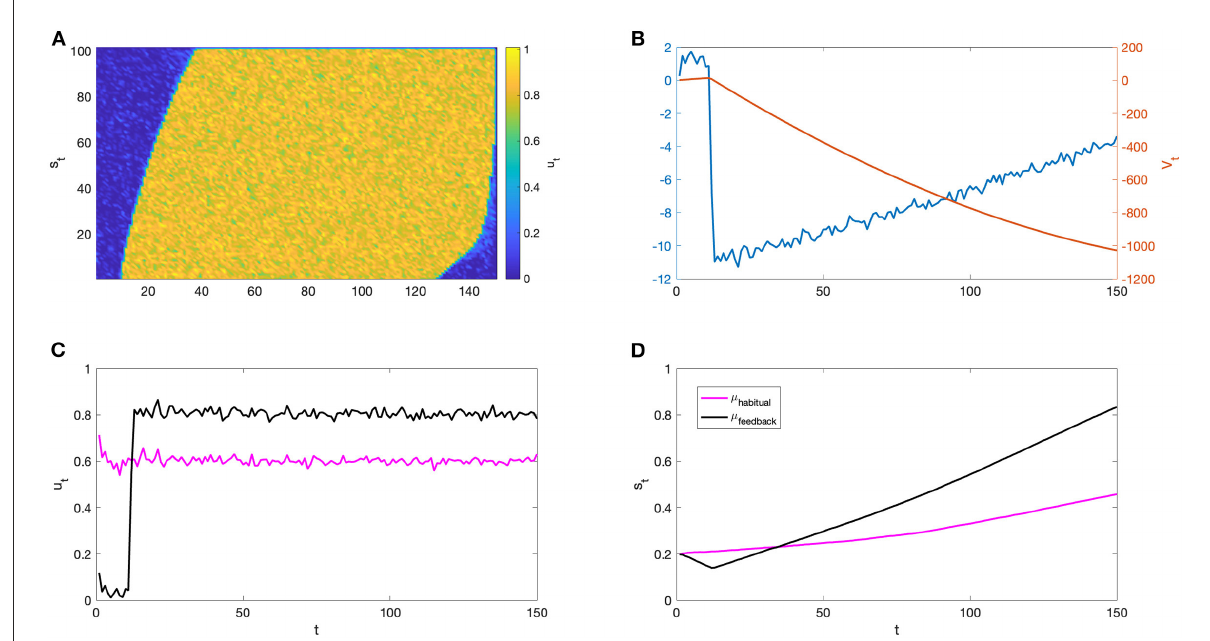
FIGURE6 Some results of the simulations. We considered an individual with p r = 0.6, low noise on the policy ( σ = 0.08), and a low initial state ( s 0 = 0.2). The other model’s parameters were fixed to α = 1, β = 1.5, γ = [3 1 0.1], and δ = 0.75. (A) reports the matrix of the optimal policy computed in the presence of the feedback loop: it indicates the decision u t (indicated by the color) to perform for each combination of time epoch and state. (B) reports the step (blue) and cumulative (red) rewards in the presence of feedback. (C, D) highlight the different evolution of the states and decisions considering habitual (magenta) and self-aware (black) behavior,